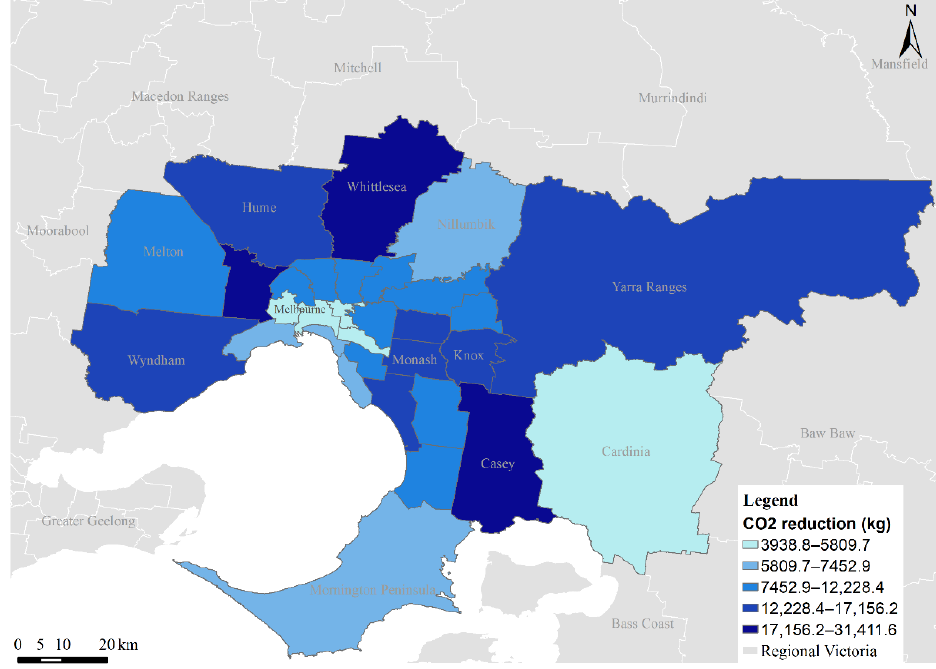
Figure 3. CO 2 emission reductions from replacing car travel to work with EVs in LGAs (AER 50 km).